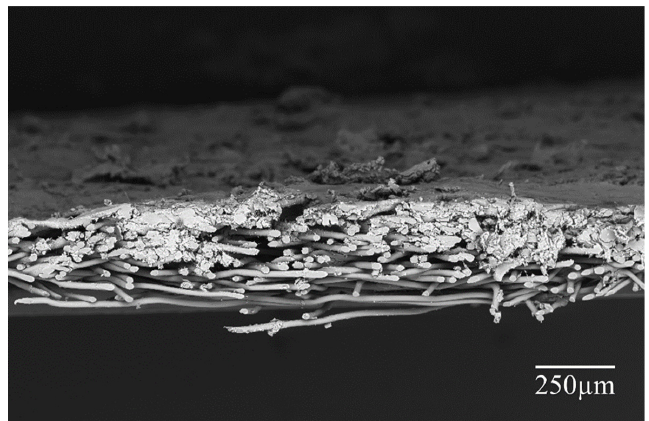
Figure 2. Typical cross section image of the electro-sprayed material.